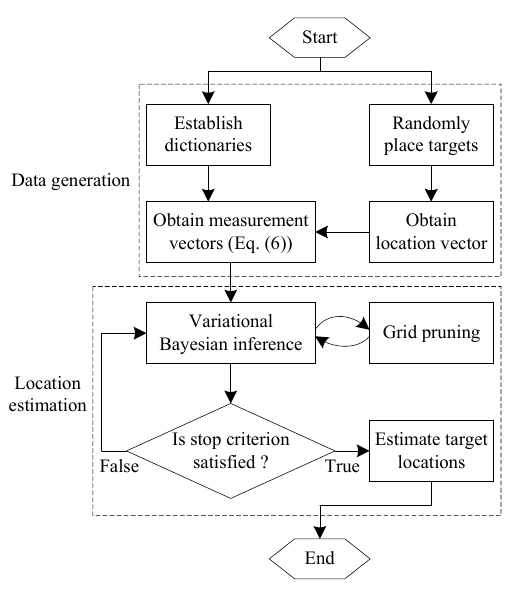
Figure 6. Simulation flowchart.